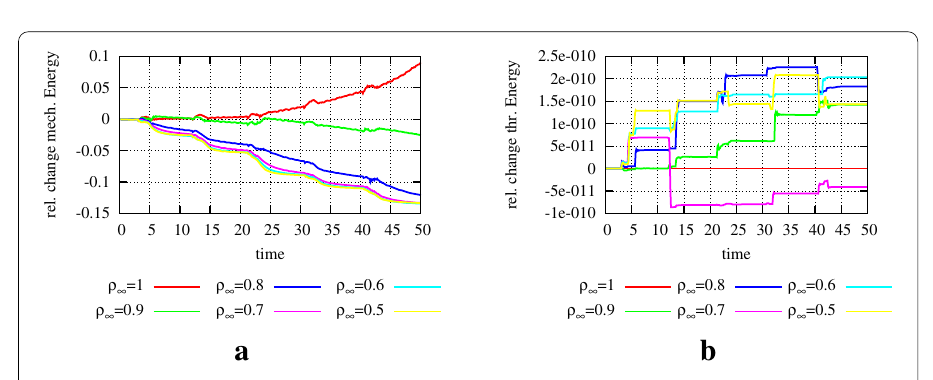
Fig. 8 Bouncing ball—relative changes in mechanical and thermal energies for different time integration parameters ρ u, ∞ = ρ T, ∞ . a Mechanical energy. b Thermal energy